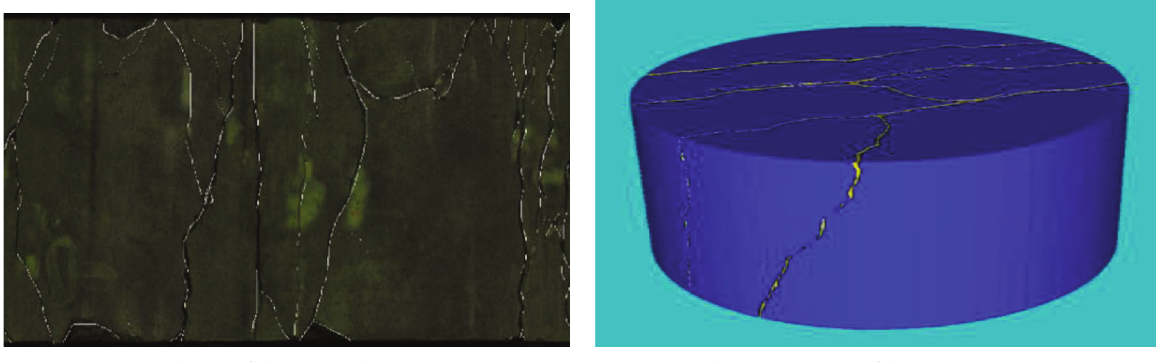
Figure 3: The 2D optical scan and the 3D CT scan of the shale